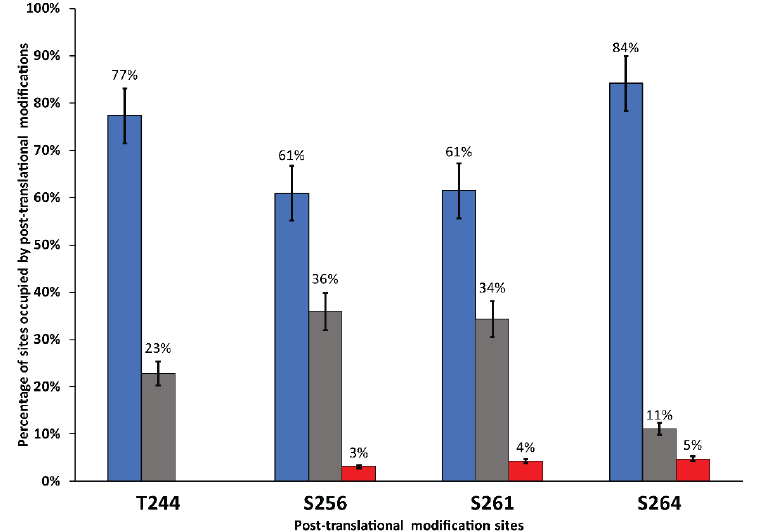
Figure 5. Percentage of peptides that contain post-translational modifications at T244, S256, S261, and S264 as predicted by ESI-MS of digested hAQP2. Unmodified sites are represented in blue, phosphorylated sites are black, and glycosylation sites are represented in red; 70 peptides covering the C-terminus were analyzed by ESI-MS.